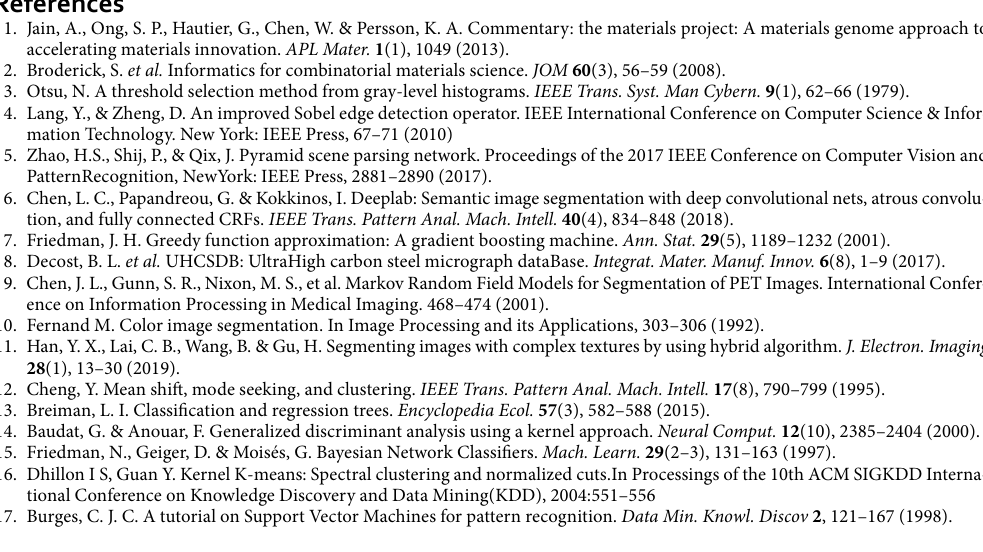
Figure 7. The flow chart of our CES method. (1) Training process of per round. R vector sets including all features of i rounds on the selected pixels. (2) Using the final model generated in training process to segment other images of the same data set. (3) Training model by using another image again if the model is not good